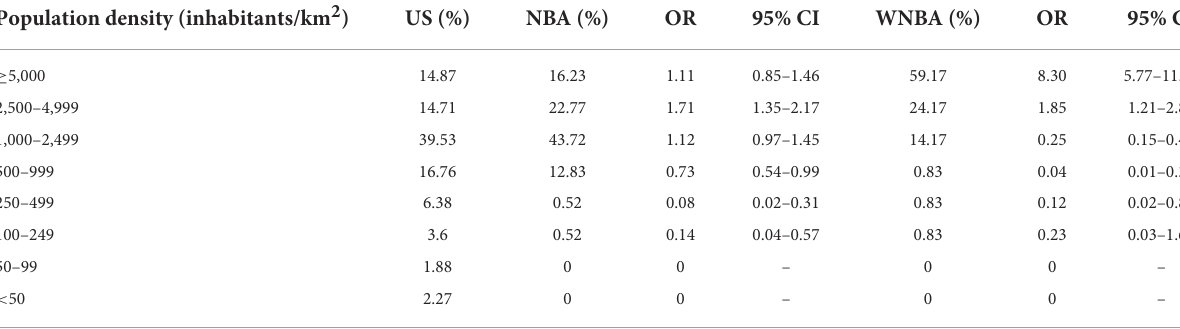
TABLE 4 Odds ratios (ORs) and confidence intervals (CIs) across population density categories for professional athletes. Population density (inhabitants/km 2